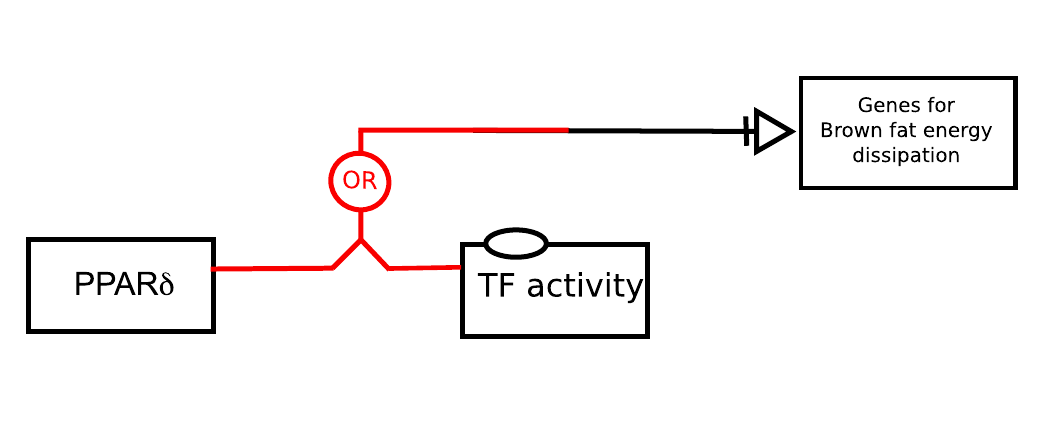
Figure 2.26: An example, taken from Figure 2.1 on page 4, of the or logic operator, where the activity from ”Genes for brown fat energy dissipation” is stimulated by either the PPAR delta activity or an unspecified transcription factor activity.